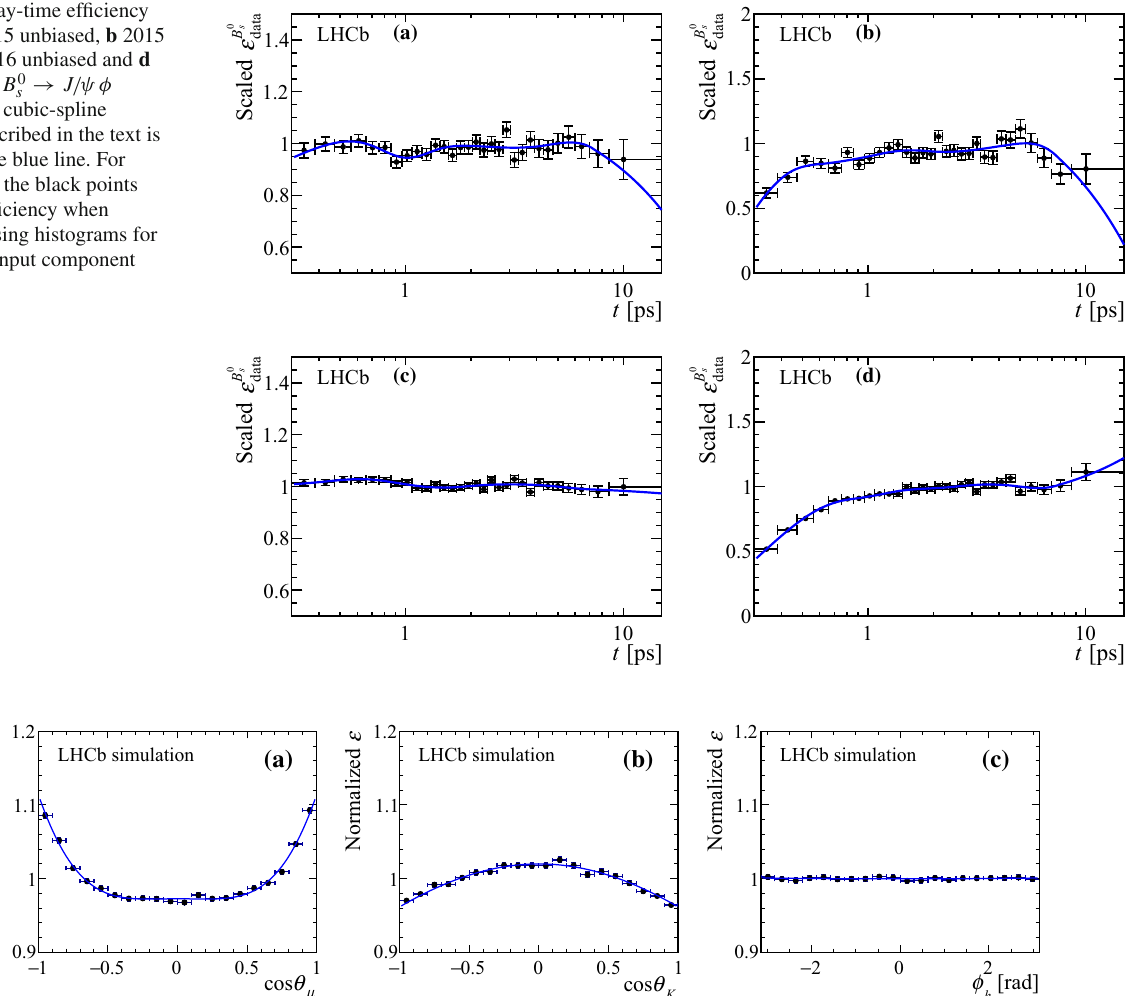
Fig. 6 Normalised angular efficiency as a function of a cos θ K , b cos θ μ and c φ h , where in all cases the efficiency is integrated over the other two angles. The efficiency is evaluated using simulated B 0 s → J /ψ φ decays that have been weighted to match the kinemat- ics and physics of B 0 s → J /ψ K + K − decays in data, as described in the text. The points are obtained by dividing the angular distribution